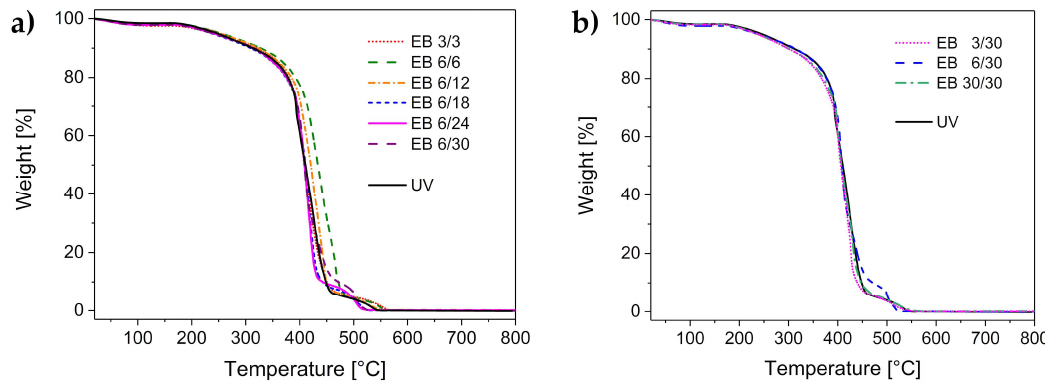
Figure 2. Thermal stability of the UV-cured hydrogels compared to the hydrogels cured with electron beam, with the variation of ( a ) the total doses and ( b ) the differential doses.